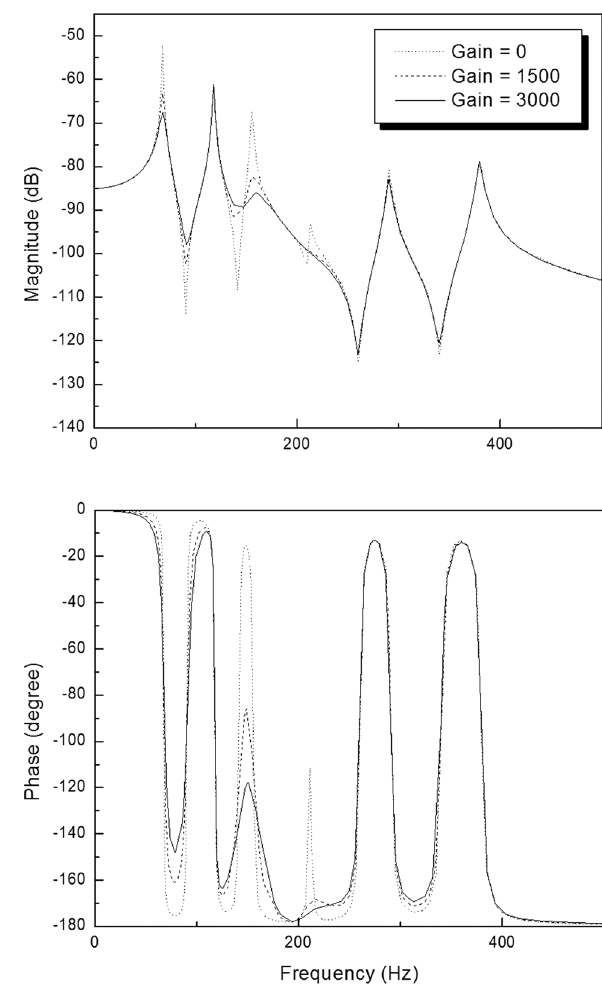
Figure 8: Response comparison of the three shear - web cases ( gain = 3,000 ) : ( a ) vertical displacement, ( b ) transverse bending and ( c ) lateral twisting.